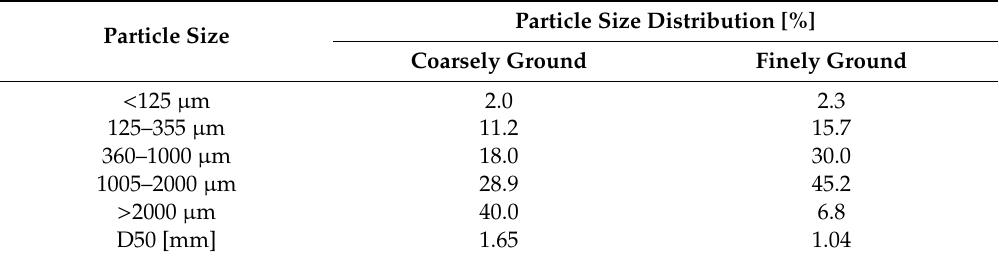
Table 4. Particle size distribution of coarsely and finely ground non-compacted before compaction. Particle